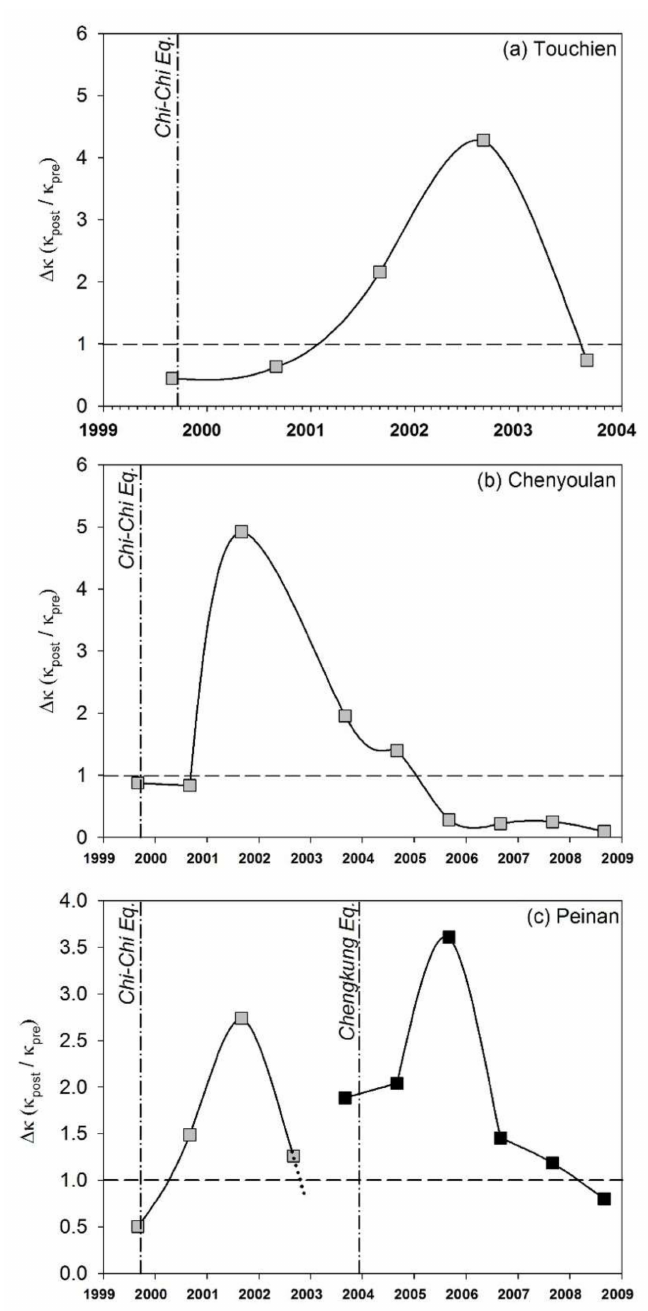
Figure 7. Variations of the ratio, ∆ κ , of unit concentration in ( a ) Touchien River, ( b ) Chenyoulan River, and ( c ) Peinan